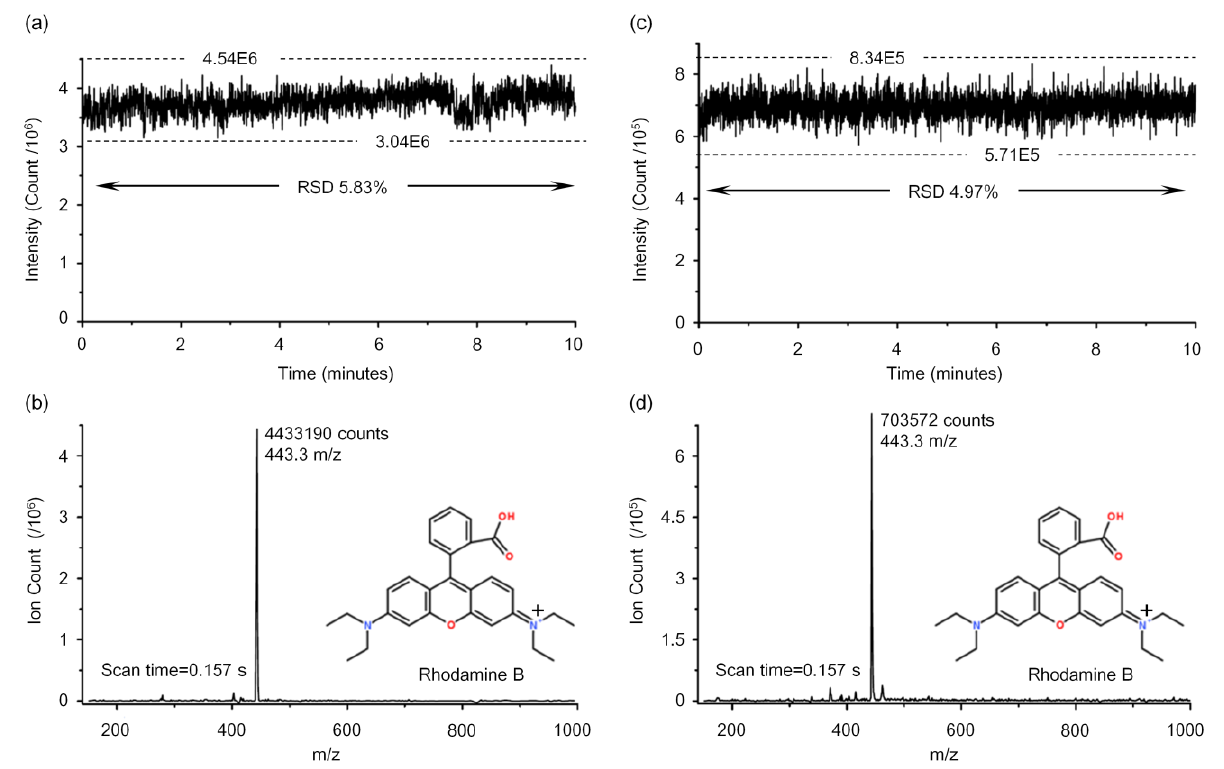
Figure 6. Data acquired while infusing 10 μM Rhodamine B in 50/50 (v/v) methanol/water containing 0.2% acetic acid at an injection pressure of 25 mbar. The electrospray potential was +4.5 kV. ( a , c ) Rhodamine B ion counts and signal stability of the proposed corner integrated emitter and the fused-silica capillary, respectively; ( b , d ) Single spectra over a 0.157 seconds scan time of the proposed corner integrated emitter and the fused-silica capillary,